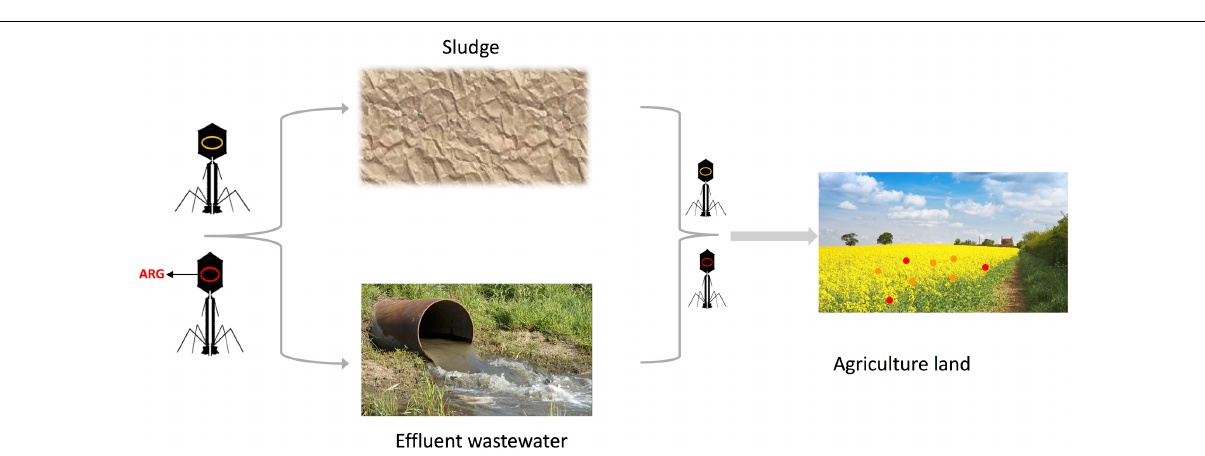
FIGURE 2 | Bacteriophage transmission of resistance genes in wastewater treatment plants (WWTPs). Bacteriophage particles loaded with Antibiotic Resistance Genes (red) will spread through effluent wastewater and sludge. The bacteriophages will encounter the natural soil microbiota and transduce those with their genetic material, rendering a proportion resistant to antibiotics (red circles), while others will not be affected (orange circles). By doing so, the bacteriophages take part in spreading antibiotic resistance, creating a reservoir of genes. Certain figures are derived from the public website